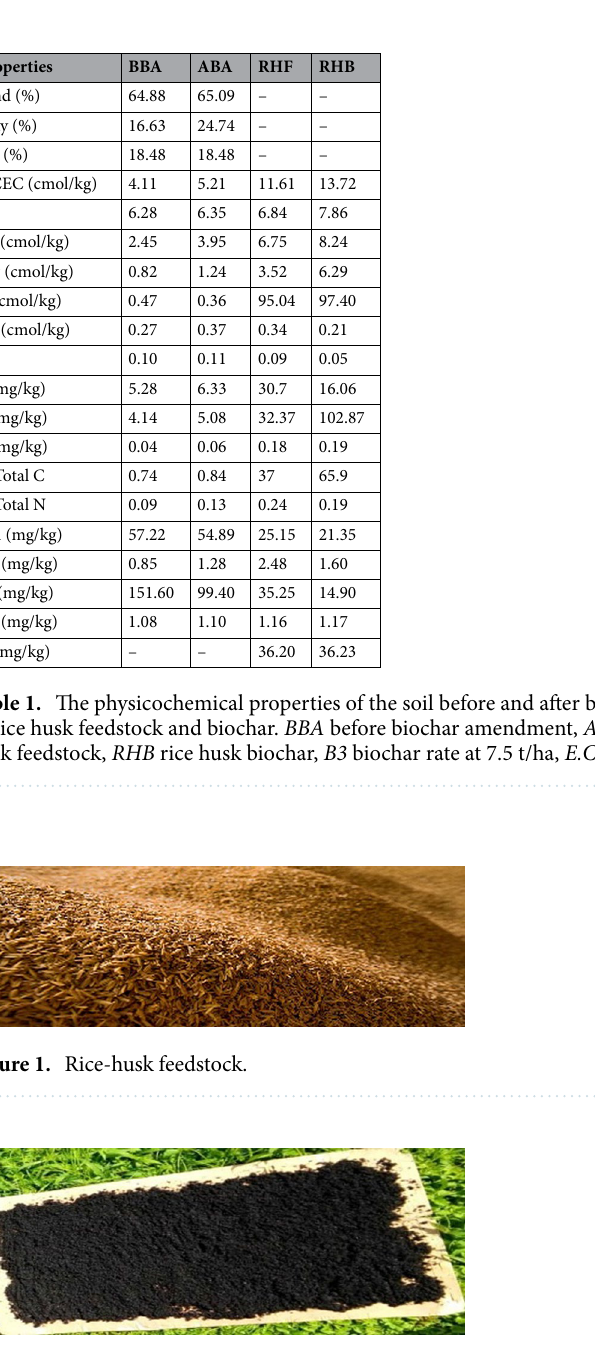
Figure 2. Rice-husk derived